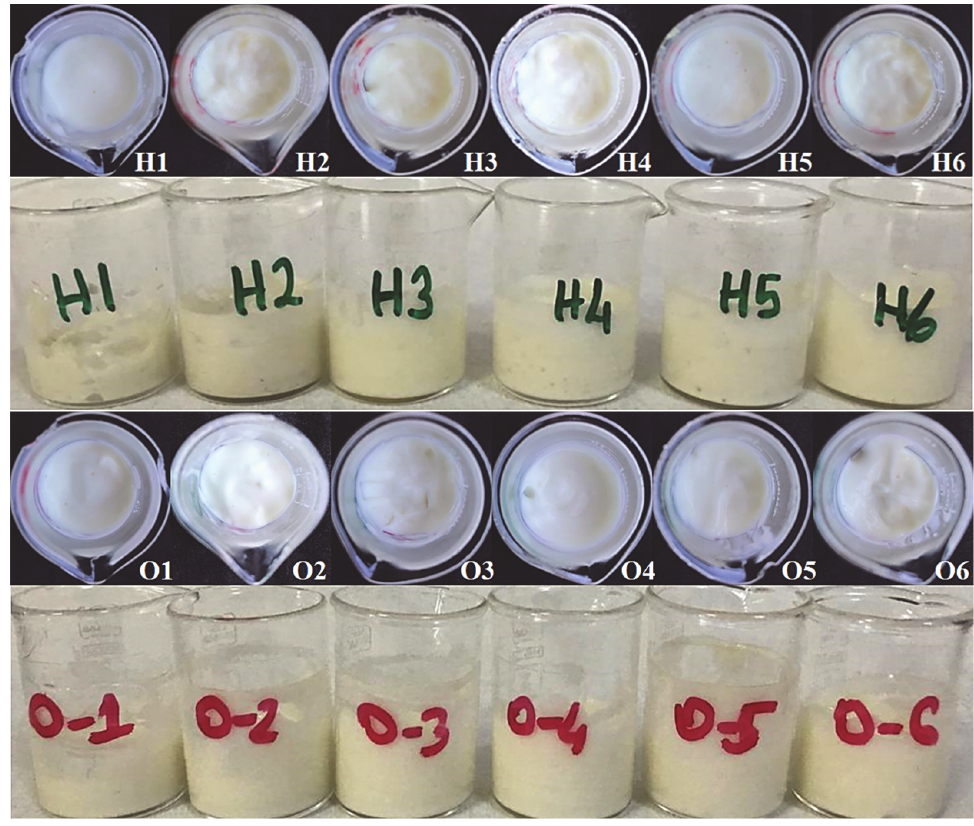
Figure 3. Top and side photographs of prepared hydrogels and organogels. Hydrogels are coded with letter H and organogels with the letter O.